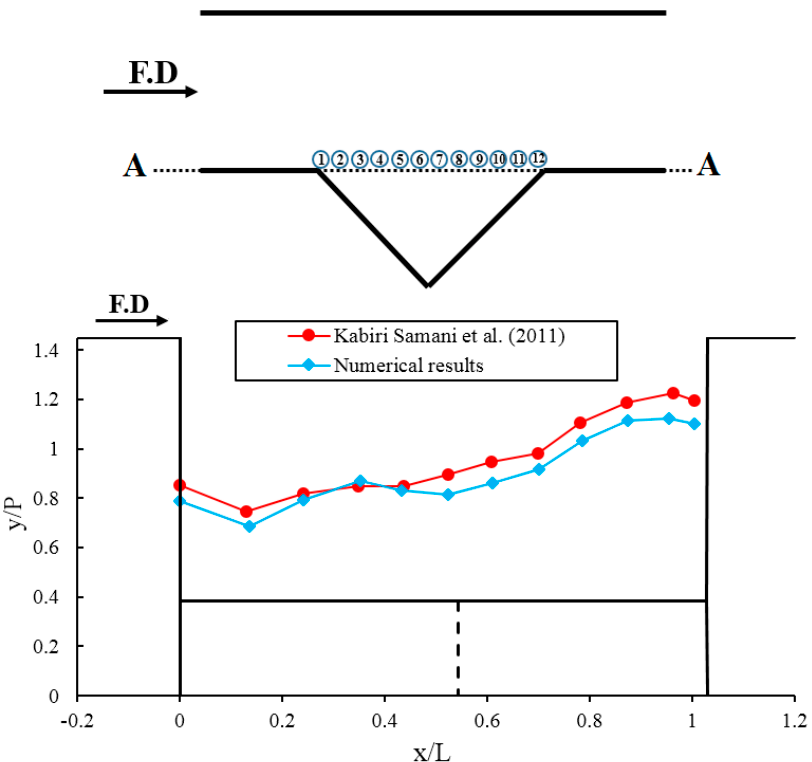
Figure 6. Comparison of the water free surface profile along the crest of the triangular labyrinth side weir (axis A-A) from numerical simulation and experimental results.